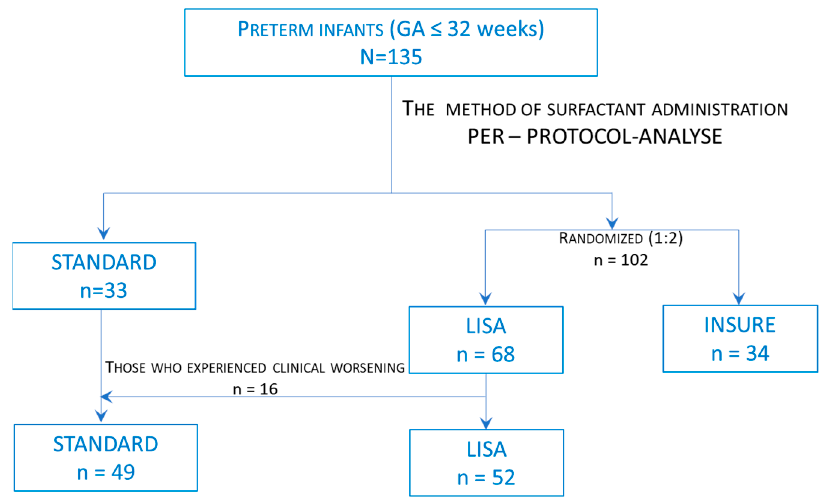
Figure 1. Flow chart for study groups.